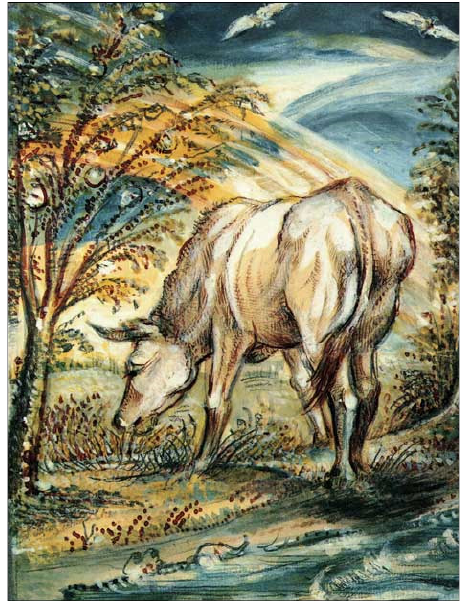
Figure 44. Konstantin Batiushkov. A Cow , 1830 (?). State Literary Museum, Moscow.